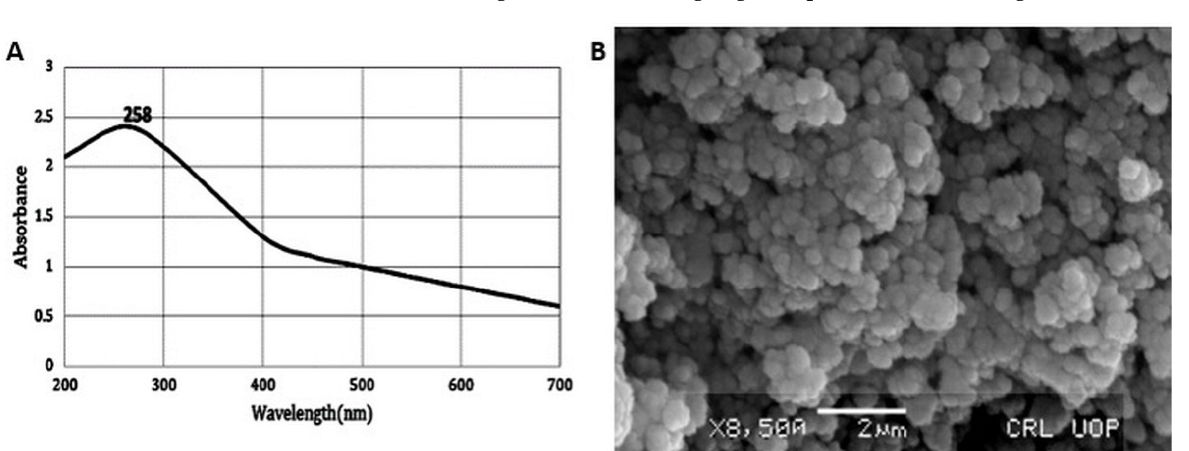
Figure 2. ( A ) UV—Visible Spectrum of SeNPs;( B ) SEM image of SeNPs. Fourier Transform Infrared spectroscopy (FT-IR). An FTIR spectrum of SeNPs was car- ried out to identify the biomolecules that might be responsible for capping, reducing, and stabilizing SeNPs in aqueous solutions. FTIR spectrum was recorded between the range of 400 and 4000 cm − 1 (Figure 2B). The FTIR spectrum was recorded and showed stretching and vibrations at wave numbers 528.51, 601.81, 800.49, 995.30, 1093.67, 1259.56, 1419.66, 1637.62, 2357.90, 2918.40, and 3410.26 cm − 1 . These peaks correspond to N-H, -C-H, -C=C, C-O-C, COOH, and C=O and indicate the role of biomolecules in the reduction and for- mation of SeNPs. The presence of these functional groups on SeNPs predicts phenols, amines, sugars, alcohols, and carboxylic acid as reducing and stabilizing agents of SeNPs. These results are well correlated with the previous study [20]. 2.2. Antimicrobial Activity of O. ferrugineamediated SeNPs The green synthesized SeNPs and O. ferruginea plant extract were tested for their an- timicrobial activity against different bacterial and fungal strains. The results presented in Figure 3 describe the effect of different concentrations (25, 50, 100, 200, and 400 ppm) of SeNPs and plant extract against phytopathogenic bacteria using the disc-diffusion method. The results showed that every treatment reduced the growth of bacterial strains